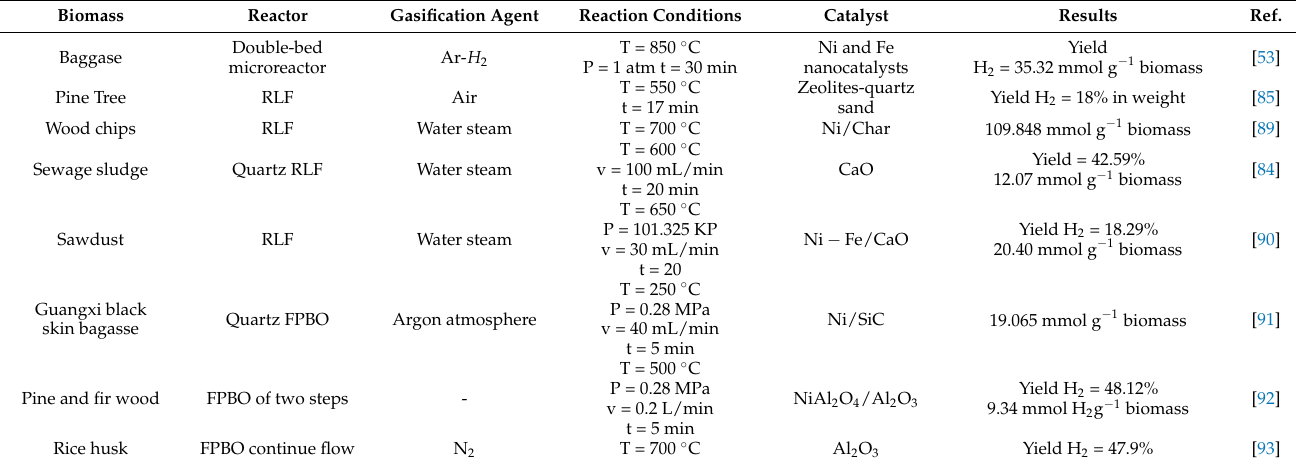
Table 3. Operating conditions and results obtained using the pyrolysis method.